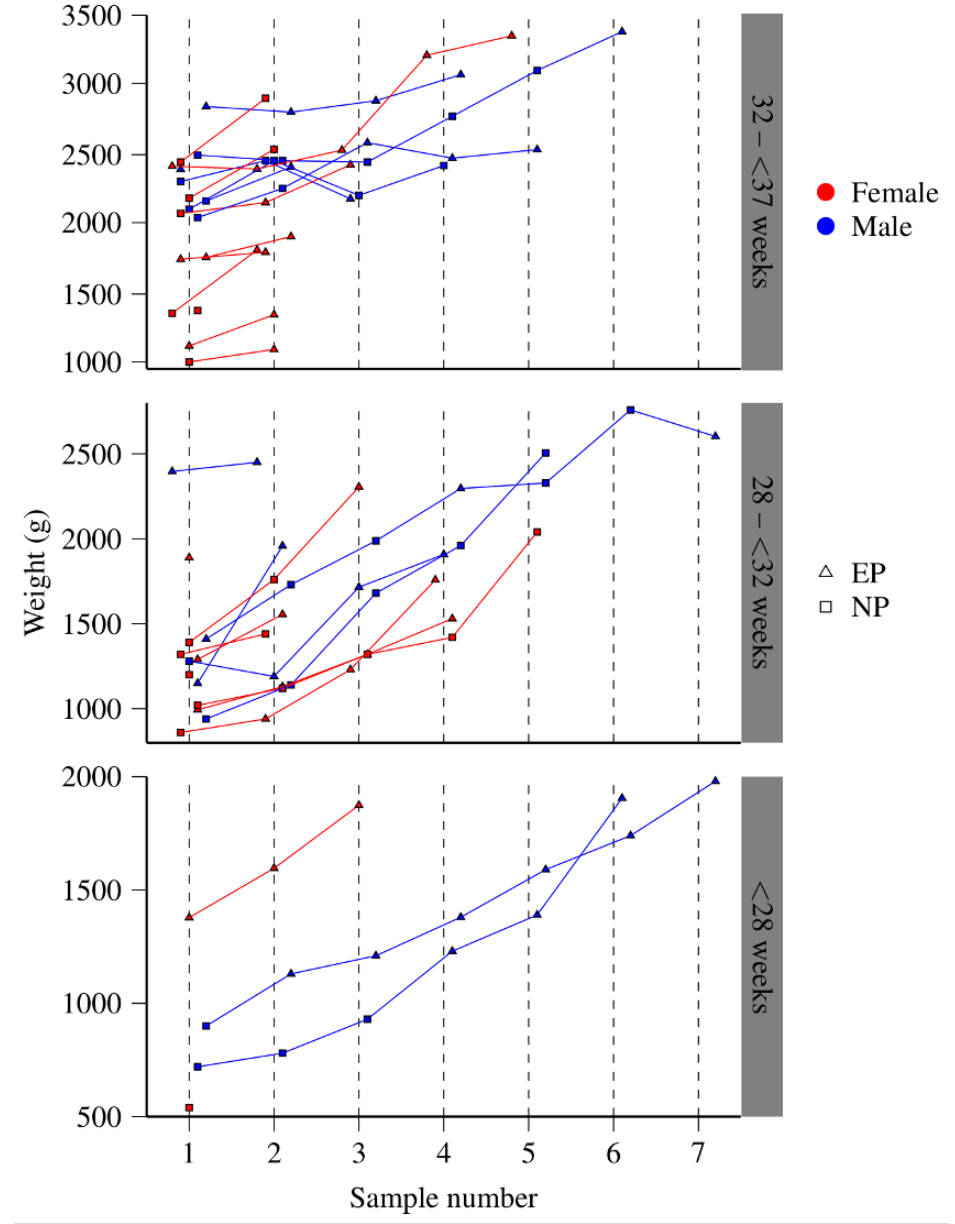
Figure 1. Number of samples and weight at the time of each sampling of the studied preterm newborns, grouped by gestational age, sex, and birth weight (107 urine samples from 34 preterm new- borns).